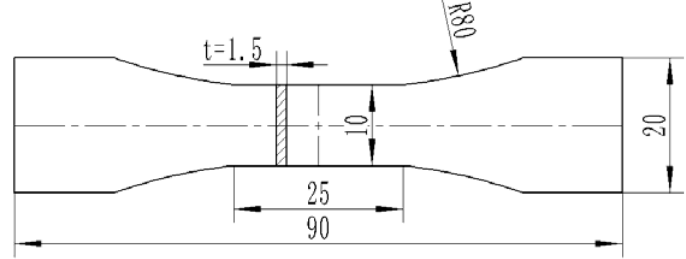
Figure 1. The sketch drawing of tensile testing specimens (unit: mm).